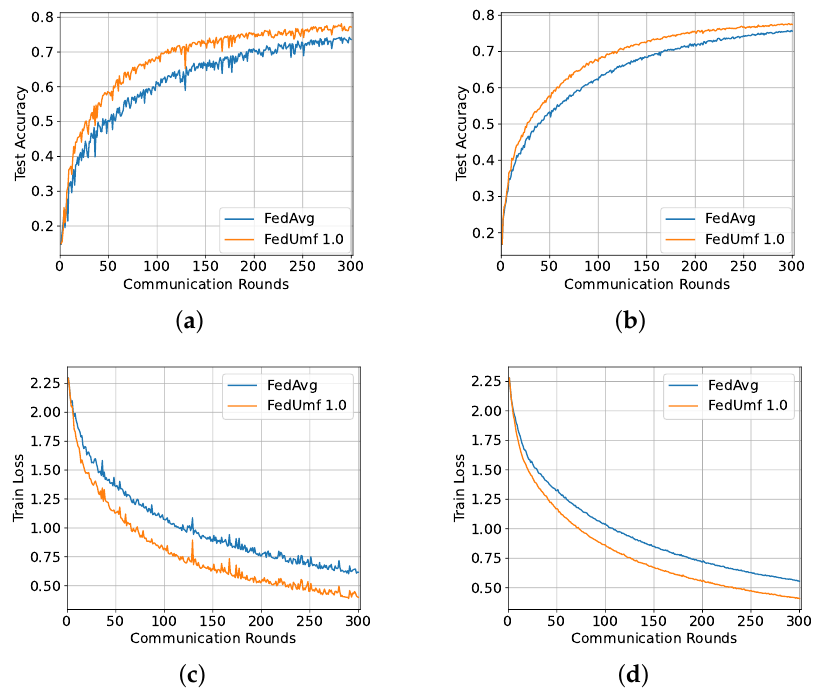
Figure 10. Server test accuracy and client-side training loss curve performance. non-IID partition, η = 0.05 on CIFAR10. ( a ) Test accuracy. C = 0.1. ( b ) Test accuracy. C = 0.5. ( c ) Training loss. C = 0.1. ( d ) Training loss. C =